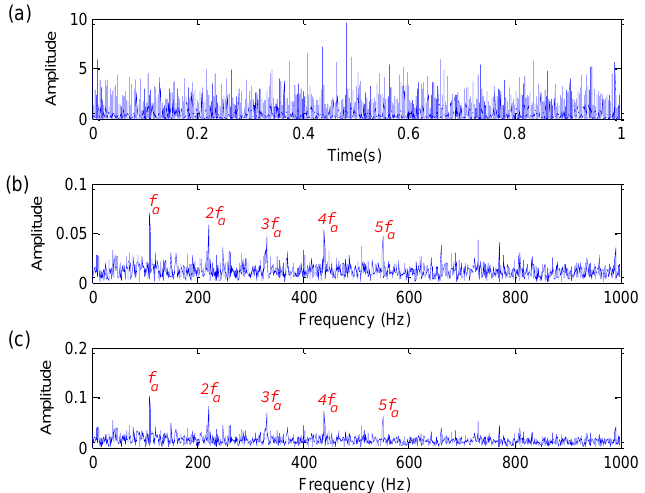
Figure 3. Analysis results obtained by the proposed method for simulation signal: ( a ) Time domain waveform; ( b ) amplitude spectrum; ( c ) envelope spectrum.